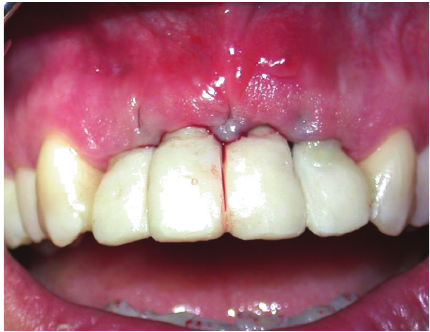
Figure 13: Soft tissue prior to delivering.